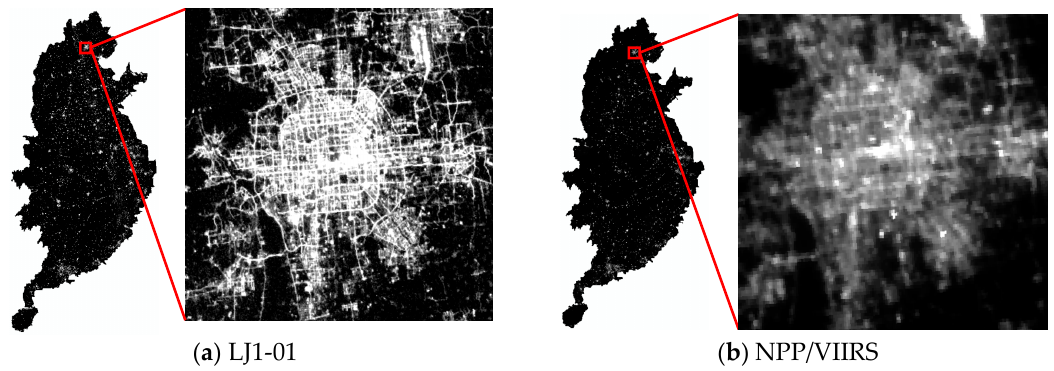
Figure 2. Nighttime light imagery of the study area. Red rectangle outlines the Beijing urban area. ( a ) LJ1-01 nighttime light imagery in 2018; ( b ) NPP/VIIRS nighttime light imagery in 2018.